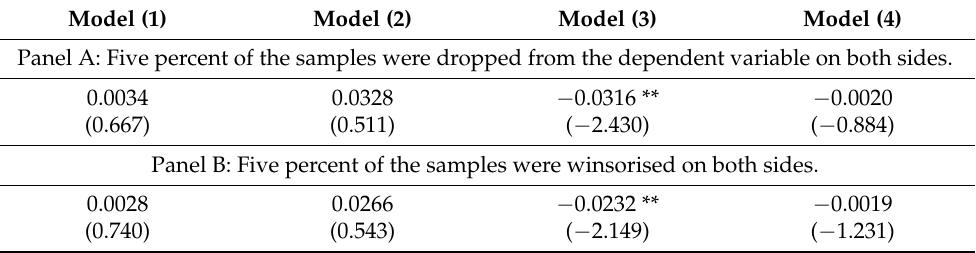
Table 14. Robustness test of LF on yield.